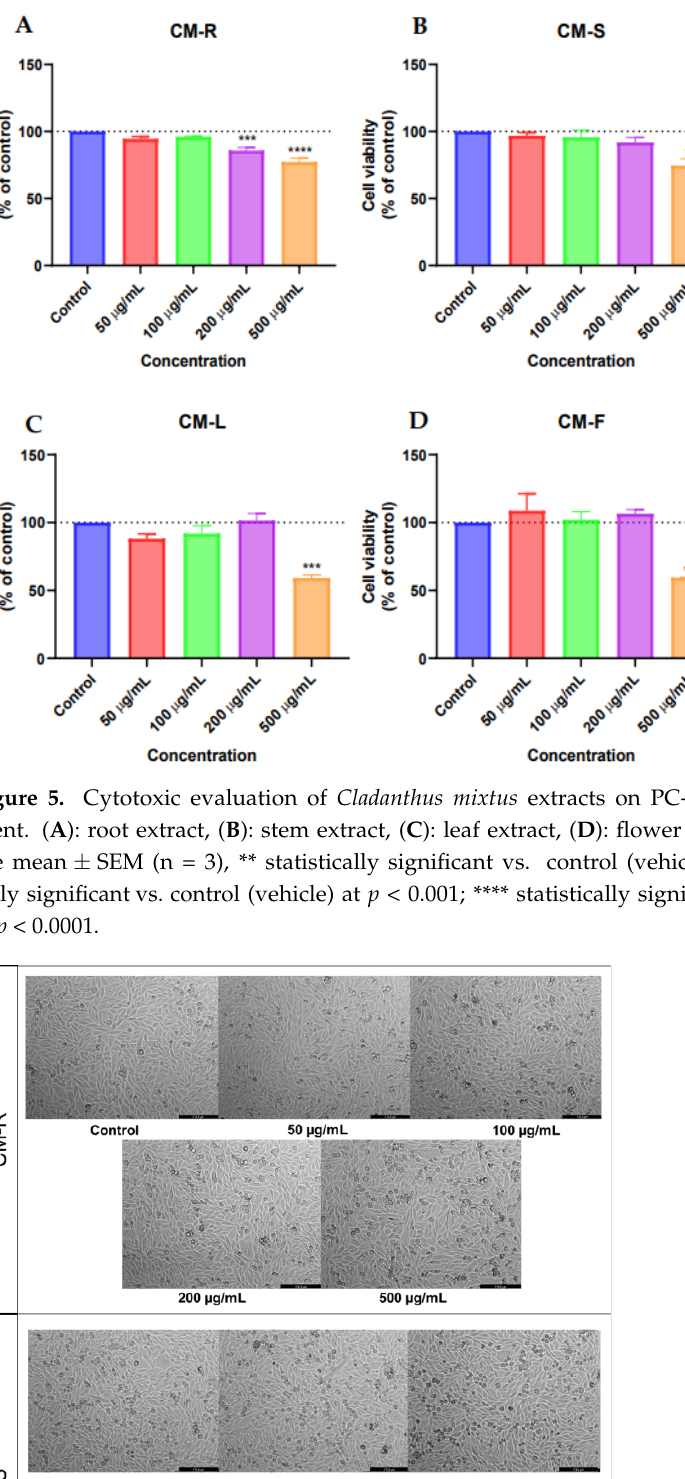
Figure 6. Morphological evaluation of PC-3 cells after 48h of treatment with Cladanthus mixtus ex- tracts. Results are representative of three independent experiments. Scale bar: 200 µm. 4. Discussion Anticancer drugs destroy cancer cells by stopping their growth or multiplication. However, some chemicals are non-selective and can target a significant portion of healthy